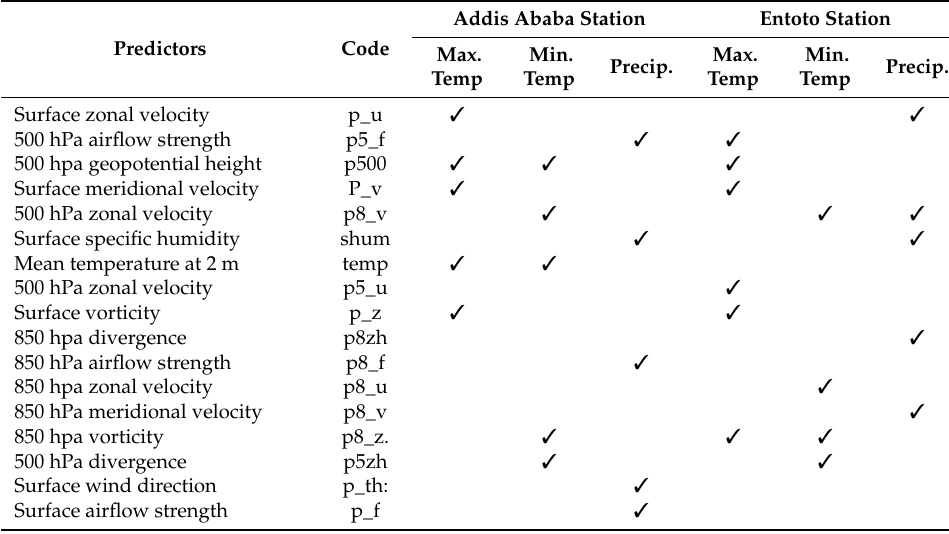
Table 1. Selected predictor variables from the General Circulation